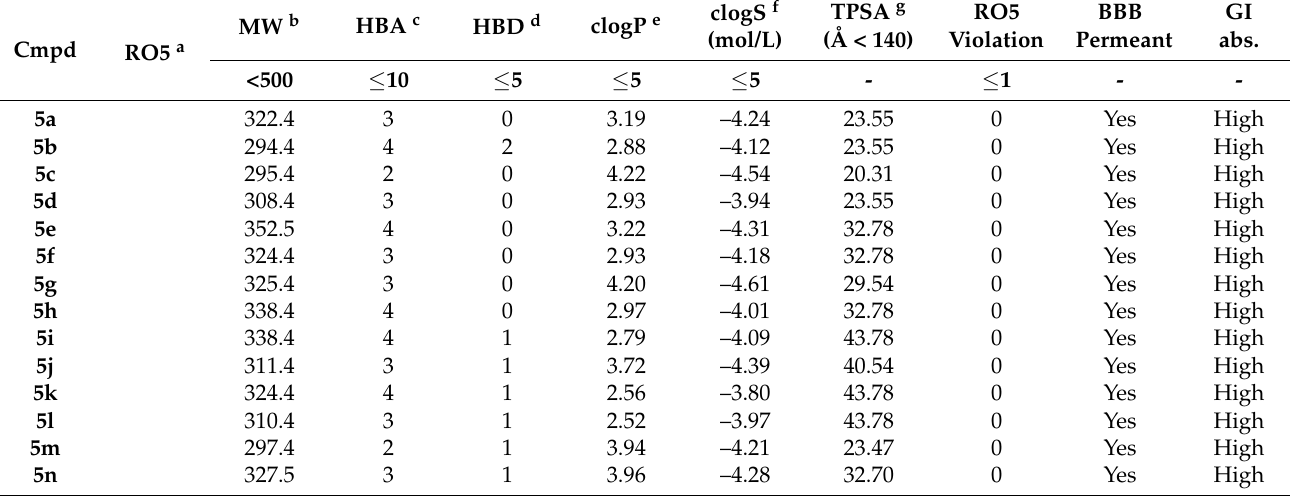
Table 1. In silico predicted main pharmacokinetic parameters of the title compounds 5a–o . Data